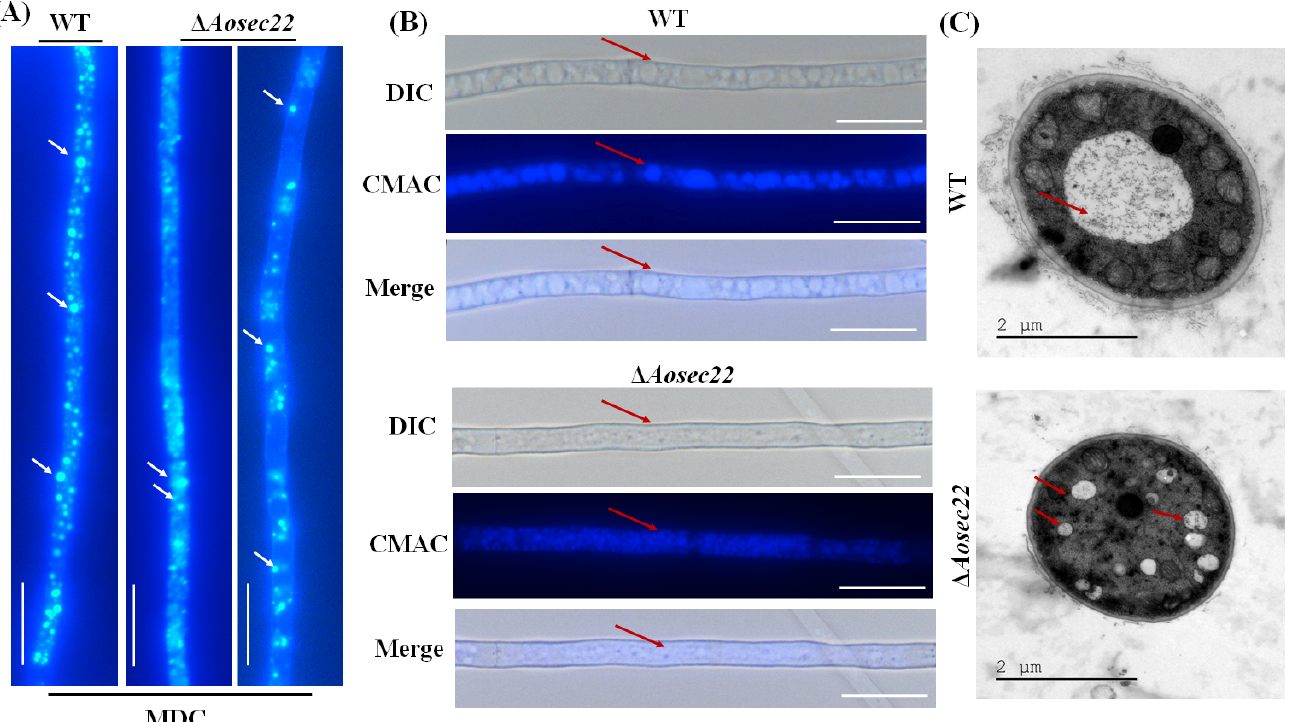
Figure 5. Impact of Aosec22 disruption on autophagy and vacuolar assembly. ( A ) Microscopic images (scale: 10 µm) of autophagosomes (arrowed) in hyphal cells stained with MDC. ( B ) Microscopic images (scale: 10 µm) of vacuoles in hyphal cells stained with CMAC. ( C ) TEM images of vacuoles in ultrathin sections of hyphal cells. Red arrows: vacuole.